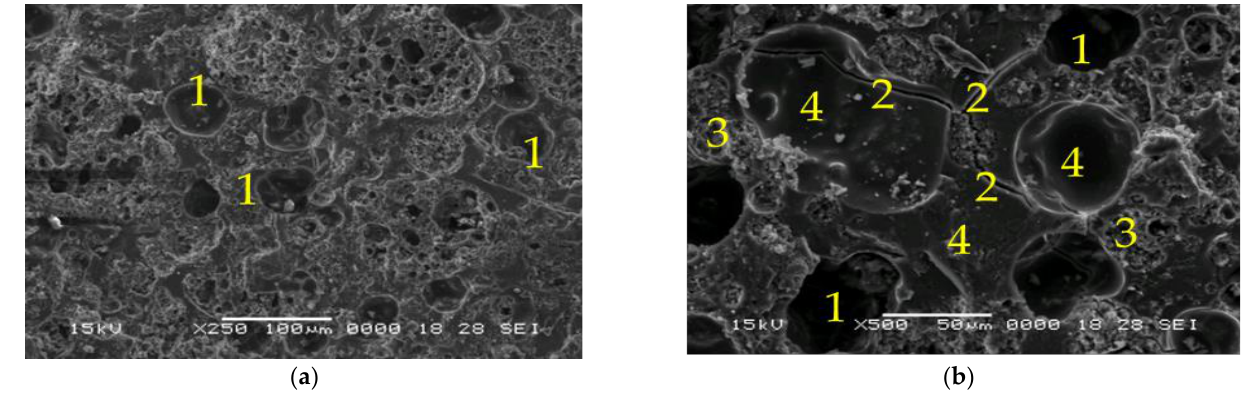
Figure 8. SEM micrographs of: ( a , b ) Sample 8M, ×250, respectively, ×1000 magnification (1 — pores, 2 — microcracks, 3 — partially reacted fly ash and 4 — dense zone of reacted fly ash) .